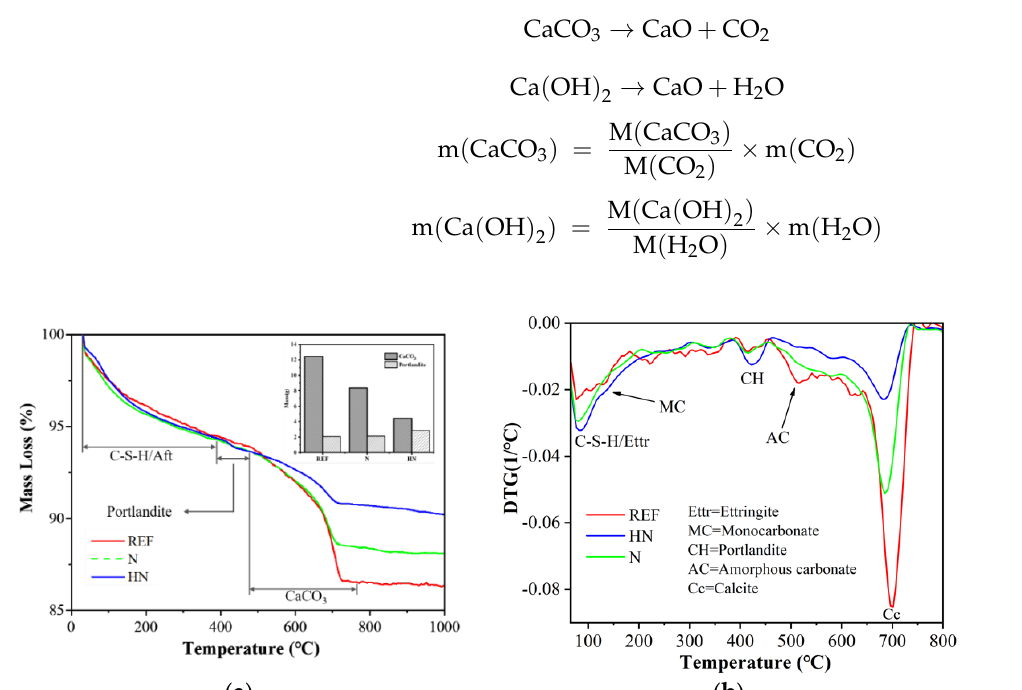
Figure 7. TG and DTG curves for different samples after carbonated for 28 days: ( a ) TG and ( b ) DTG.